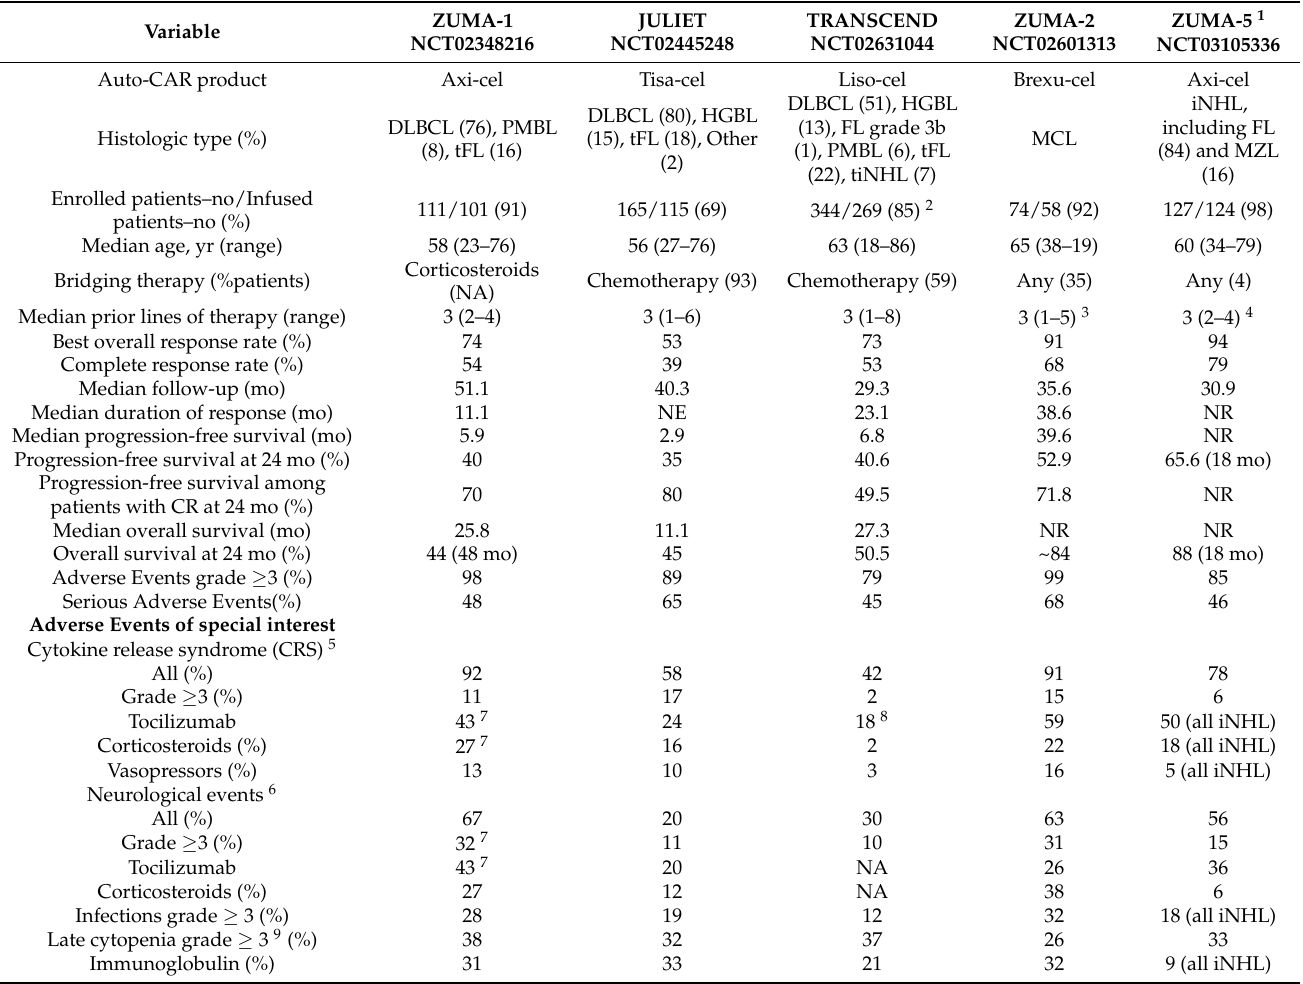
Table 2. Characteristics and results of pivotal clinical trials for CD 19 auto-CAR T cell therapies approved in relapsed/refractory B cell